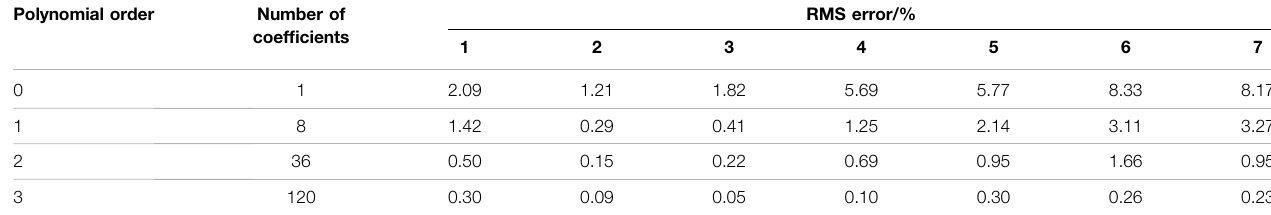
TABLE 2 | Relative fi tting errors of the different energy-group PDF by different predication function. Polynomial order Number of coef fi cients